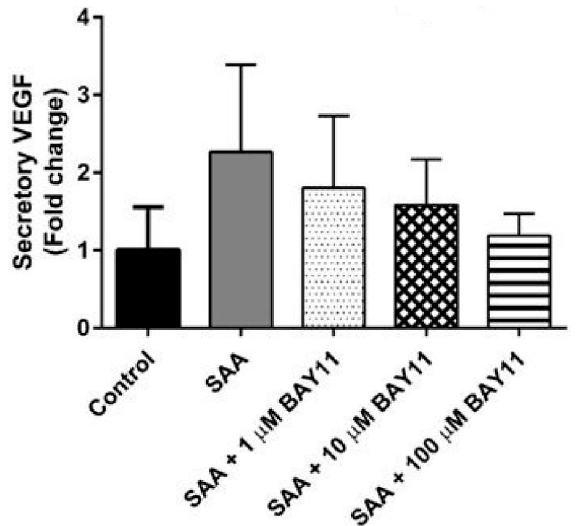
Figure 1. Secretion of VEGF from HCtAEC in response to SAA in the absence and presence of the NF κ B inhibitor BAY11-7082. HCtAEC were pre-incubated (1.5 h) with 0, 1, 10 or 100 µ M BAY11-7082 or vehicle (control) then treated with 10 µ g/mL SAA. After 4.5 h the levels of secretory VEGF in cell supernatants was assessed by commercial ELISA assays. Data were expressed as a fold-change compared to control cells. Data represents the mean ± SD (n = 4 individual experiments, each performed in duplicate; therefore, data represent 4 technical replicates). * p < 0.05 compared to control cells. All data was normalised to the corresponding level of cell confluence (expressed as a percentage %) determined using an IncuCyte system immediately prior to cell harvest for ELISA. This approach to normalizing data was necessary as there was some level of toxicity for BAY11-7082 particularly at the higher doses of inhibitor tested.